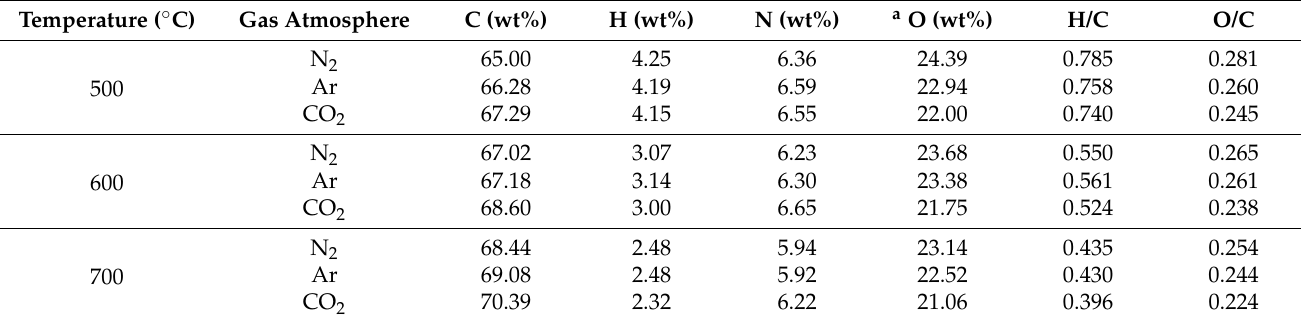
Table 2. Results of ultimate analysis of BSG char in an air-dry